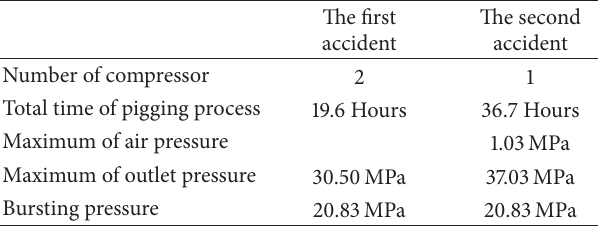
Table 4: Summary of the field trial and numerical simulation. The field trial